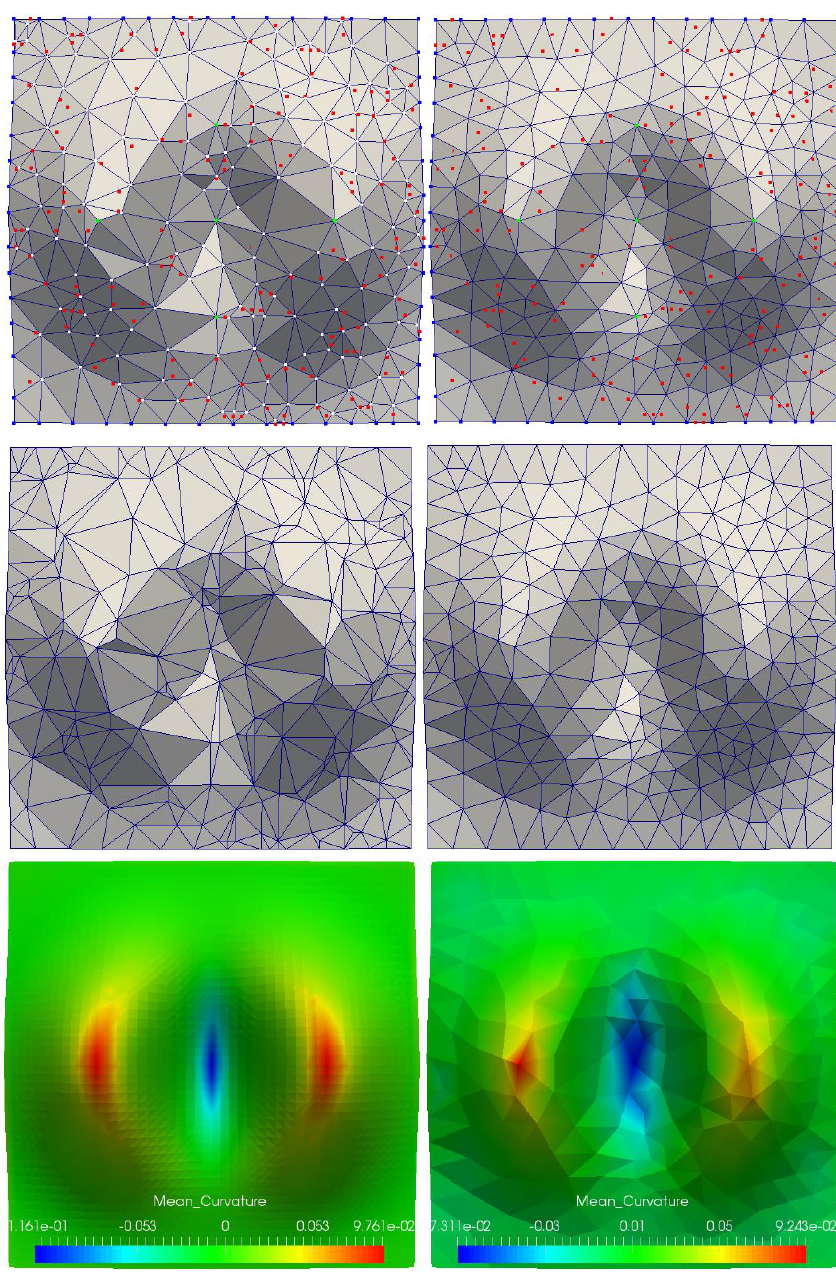
Figure 8. Comparison of converged results. Top left: reconstructed TIN surface from one iteration, with the initial points presented. Top right: the converged TIN surface with the initial sites, after approximately 140 loops. Middle: the initial approximated TIN surface (left) and the final TIN surface (right). Bottom: curvature distribution on the original surface (left) and the generalised grid